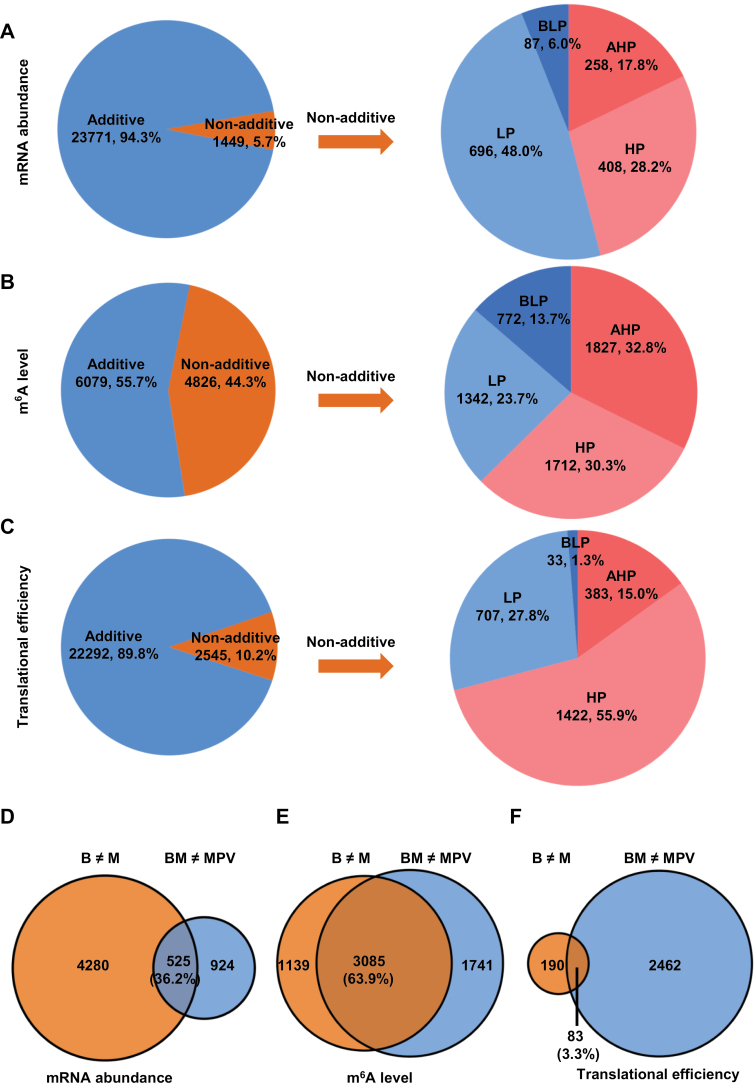
Heterotic patterns at the levels of mRNA abundance, m6A modification, and translational efficiency in the hybrid. (A–C) Additive and non-additive variation and subdivided patterns of non-additive variation (AHP, above higher parent; HP, high parent; LP, low parent; BLP, below lower parent) at the levels of mRNA abundance (A), m6A modification (B), and translational efficiency (C) in the hybrid. The numbers and percentages of genes exhibiting additive and non-additive variation as well as subdivided patterns of non-additive variation are displayed. (D–F) Contribution to non-additive variation in the hybrid by the divergence of parents at the levels of mRNA abundance (D), m6A modification (E), and translational efficiency (F). B≠M, significant difference between parents; BM≠MPV, significant difference between hybrid and MPV. B, B73; BM, B73×Mo17; M, Mo17.